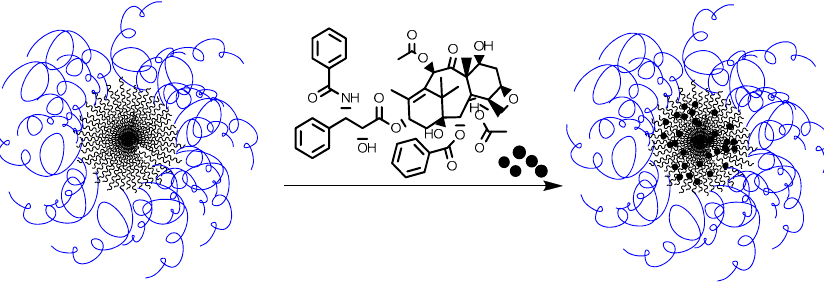
Figure 13. Scheme of paclitaxel encapsulation into PMAG- b -PGlu(OBzl) micelles.